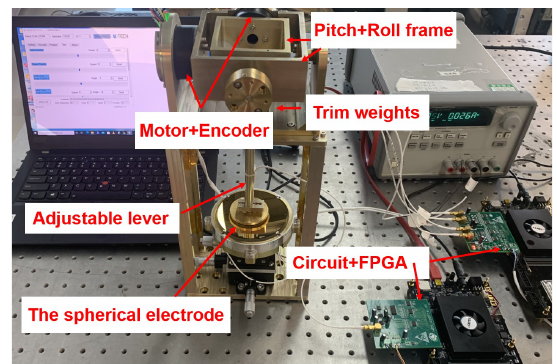
Figure 15. Capacitive sensor